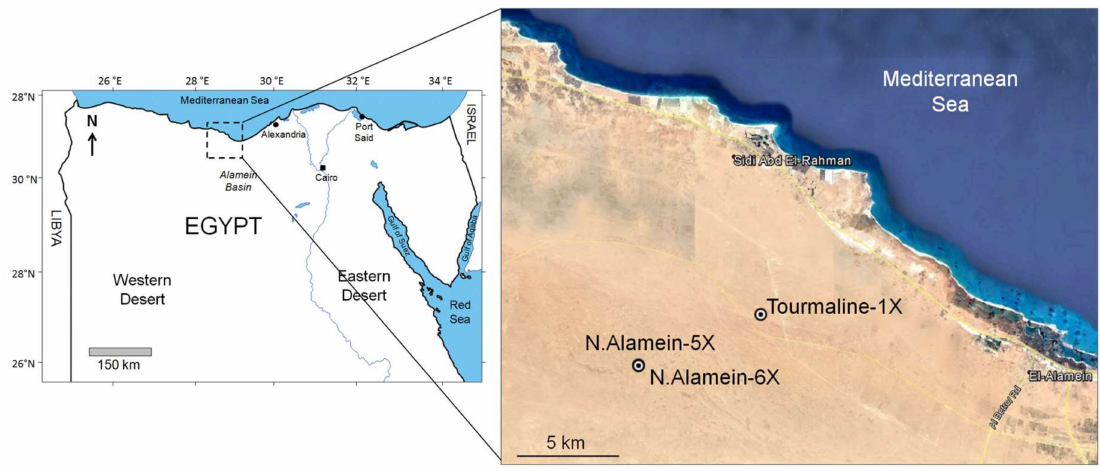
Figure 1. Location of the project wells within Alamein Field, Western Desert,